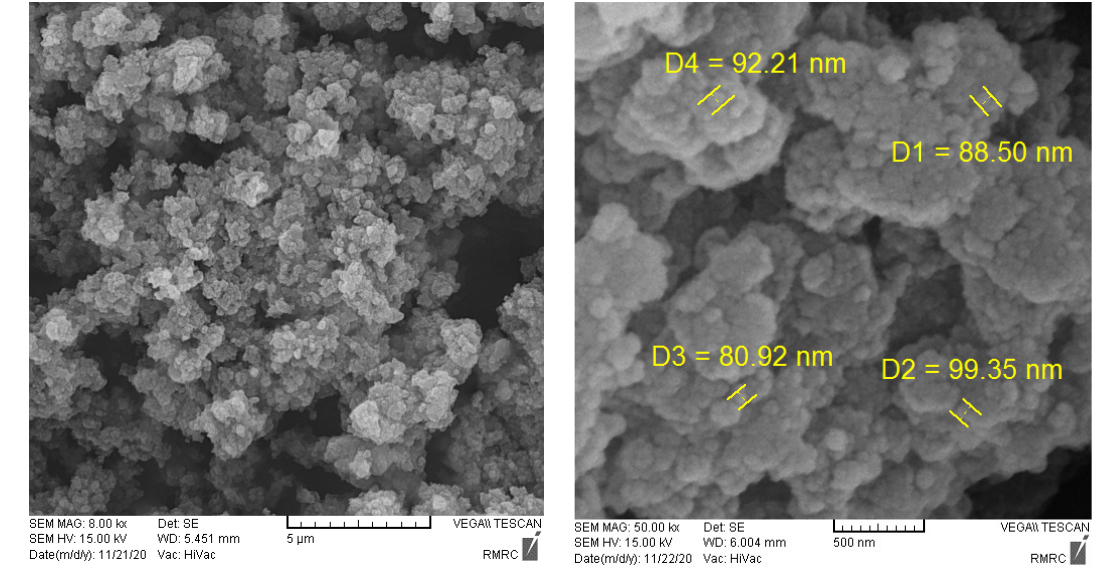
Fig. 3. SEM images of MIPs